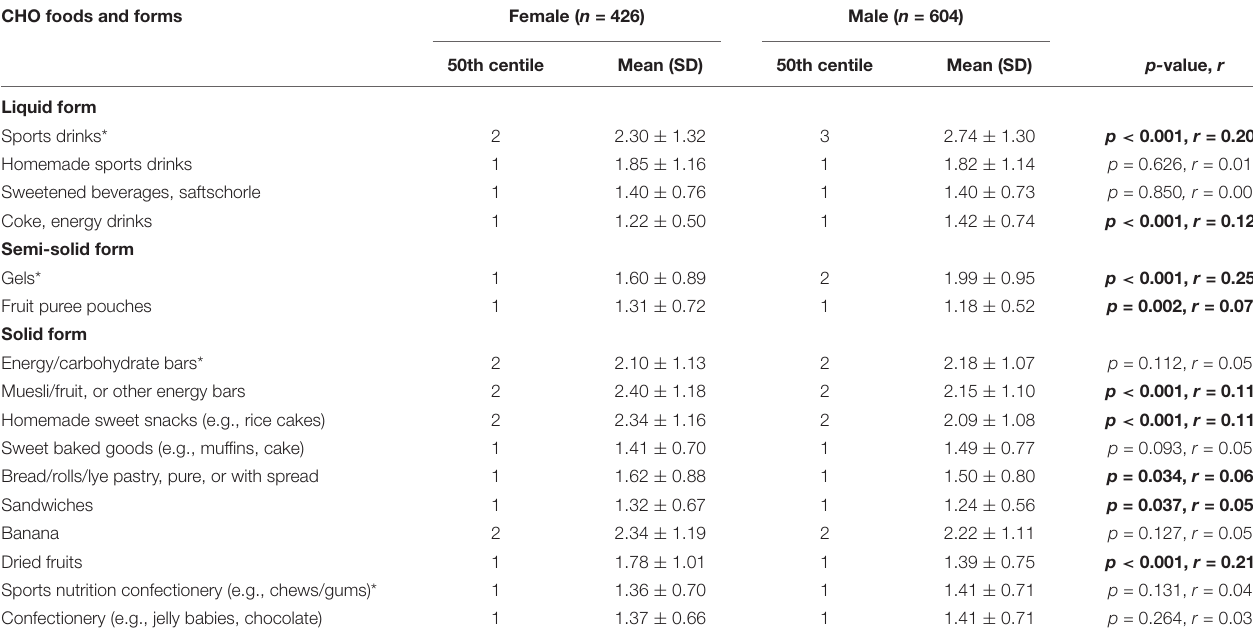
TABLE 3 | Sex-based differences in intake frequencies of carbohydrate foods during training at low-to-moderate exercise intensities. CHO foods and